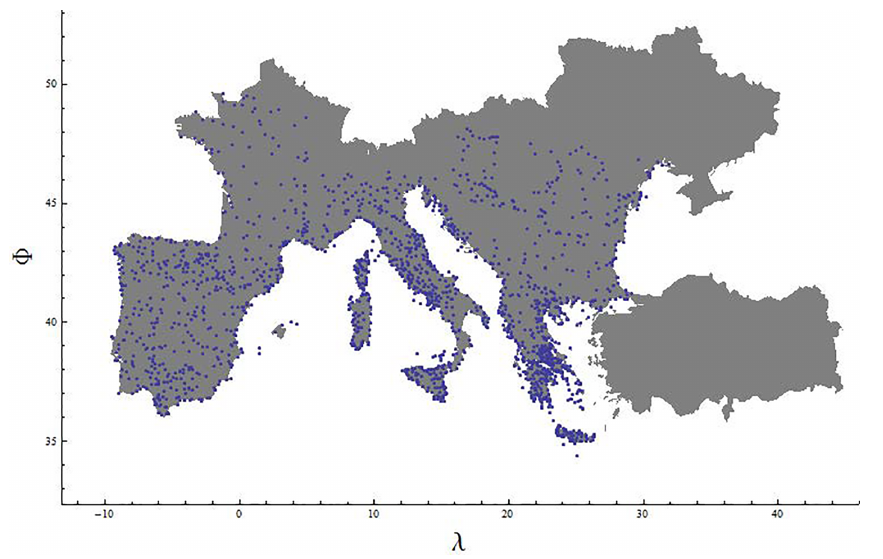
Figure 1. Map of contemporary counterparts of Ptolemy’s locations considered in the present analysis on a map (blue dots).